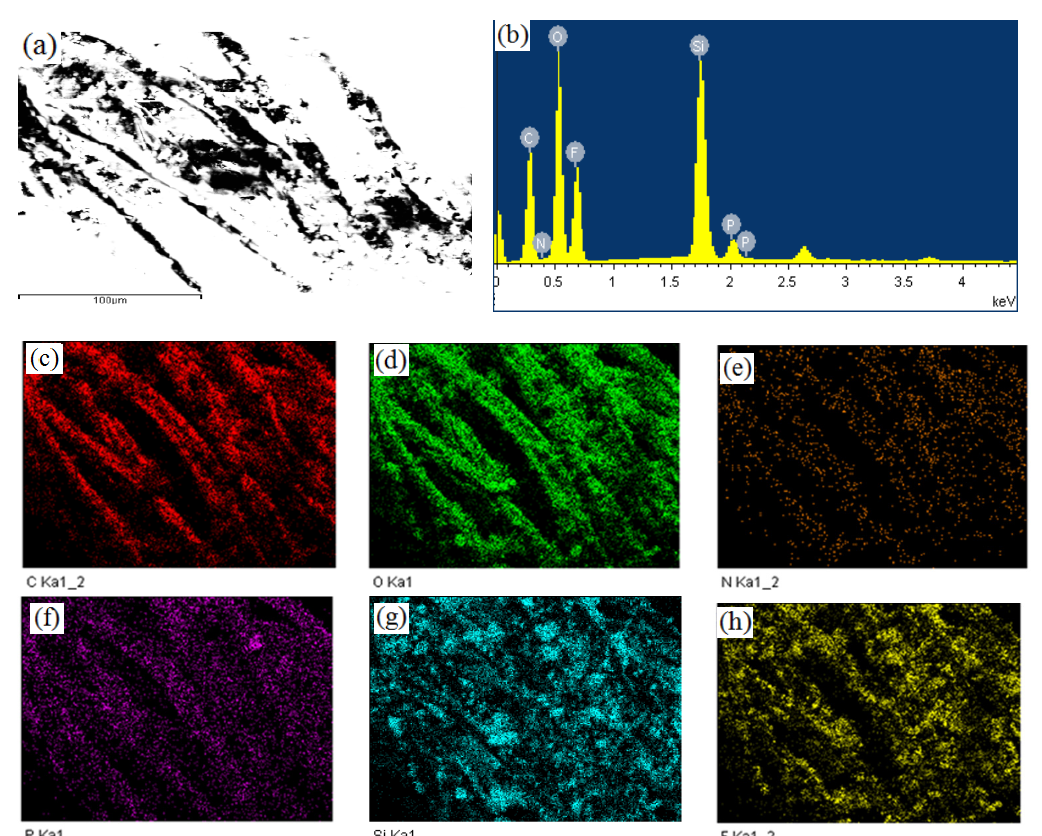
Figure 5. EDS spectrum of the BAPC cotton fabric: ( a ) SEM image of the area, ( b ) general elemental map and the corresponding element distribution of ( c ) C, ( d ) O, ( e ) N, ( f ) P, ( g ) Si and ( h ) F.